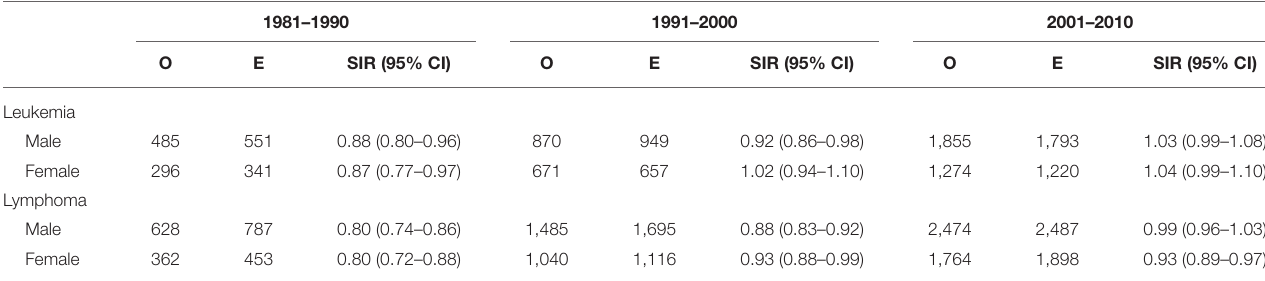
TABLE 2 | The standardized incidence ratio (SIR) and its 95% confidence interval (CI) associated with the high exposure category relative to the low exposure category by sex and time